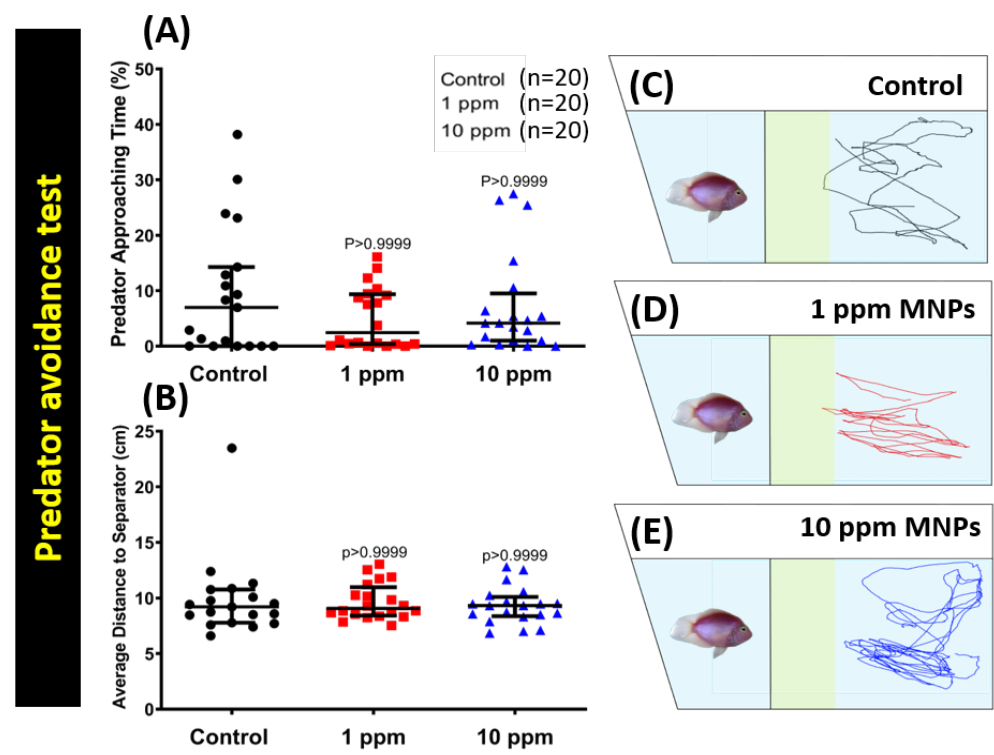
Figure 4. Predator avoidance behavior endpoint comparisons between control, 1 ppm, and 10 ppm Fe 3 O 4 MNPs-exposed zebrafish groups after two weeks of exposure. ( A ) Predator approaching time percentage and ( B ) average distance to the separator were analyzed. The locomotion trajectories for the control, 1 ppm, and 10 ppm MNPs exposed fish in the predator avoidance test were presented in ( C – E ), respectively. The data are expressed as the median with interquartile range and were analyzed by the Kruskal-Wallis test with Dunn’s multiple comparisons test as a follow-up test ( n = 19 for the control group, n = 20 for 1 ppm MNPs-exposed group, and n = 20 for 10 ppm MNPs exposed group).